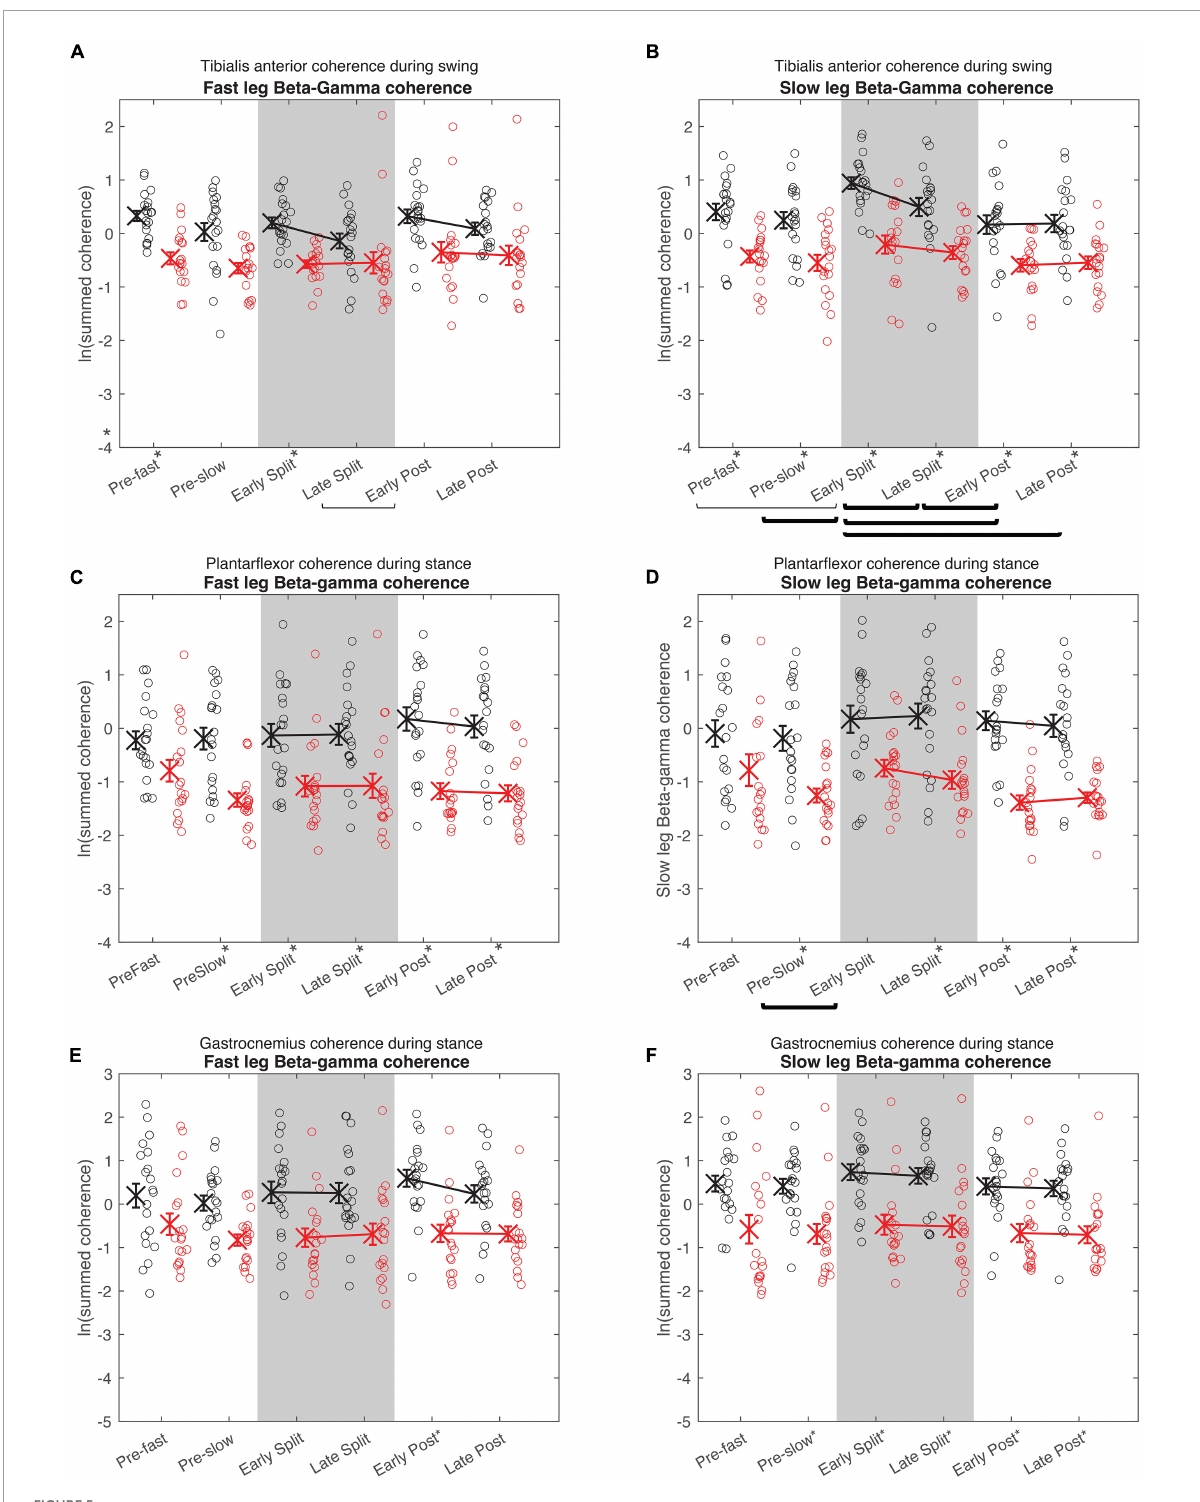
FIGURE5 Cumulative beta-gamma electromyography-electromyography coherence. Intramuscular coherence between the distal and proximal tibialis anterior during swing phase (A,B) , intermuscular coherence between the medial gastrocnemius and soleus during stance phase (B,C) , and coherence between the medial and lateral gastrocnemius during stance phase (E,F) in the fast (A,C,E) and slow leg (B,D,F) . Black = Young; Red = Old; X = group means; Error bars = standard error. Brackets indicate between-condition comparisons where p < 0.05. Thick brackets indicate speed-matched between-condition comparisons where p < 0.05. * indicates between-groups comparisons within condition where p < 0.05. All comparisons were corrected for multiple comparisons using the Bonferroni